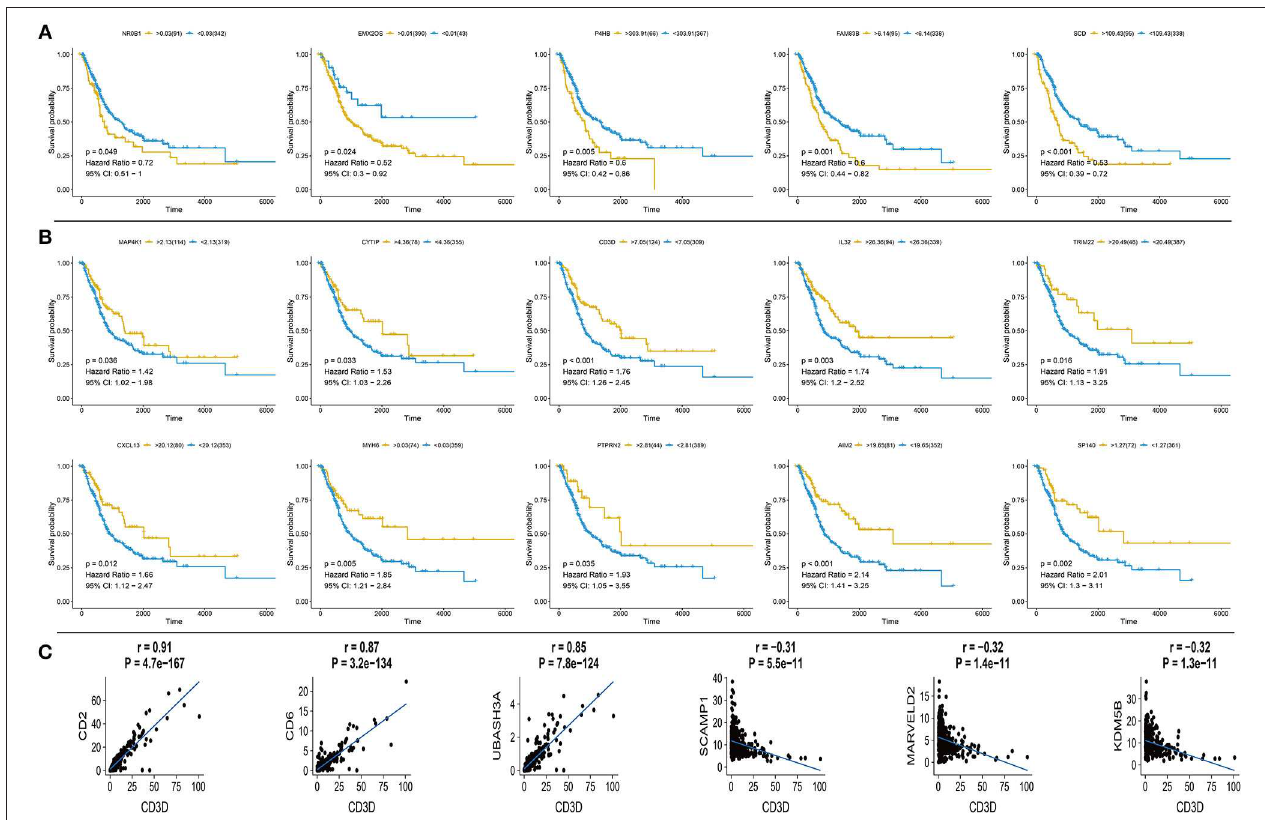
FIGURE 3 | Survival curve for hub genes of 433 TCGA bladder cancer samples and analysis of Pearson’s correlation of CD3D (A) Five up-regulated hub genes with poor prognosis in bladder cancer, p -value, Hazard ration, and 95% CI are shown. (B) Ten down-regulated hub genes with poor prognosis in bladder cancer, p value, Hazard ration and 95% CI are shown. (C) Pearson’s correlation of CD3D with top 3 positive and negative genes in bladder cancer from TCGA database, relevant gene expression versus change upon CD3D, p -value and correlation are shown.